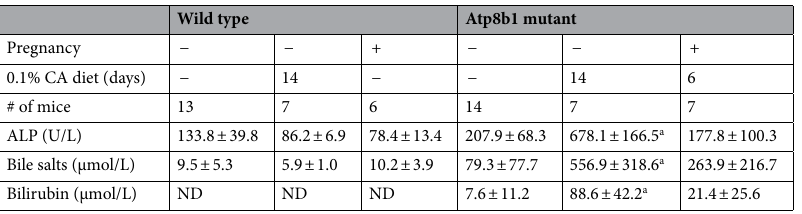
Table 1. Plasma parameters of non-pregnant and pregnant WT and Atp8b1 mutant mice on the indicated diet. Diet was administered during the indicated period before measurement Numbers reflect mean ± SD. ND not detectable. Statistics: a indicates significant ( p < 0.01) increase compared to same genotype before introduction of the 0.1% CA diet (paired